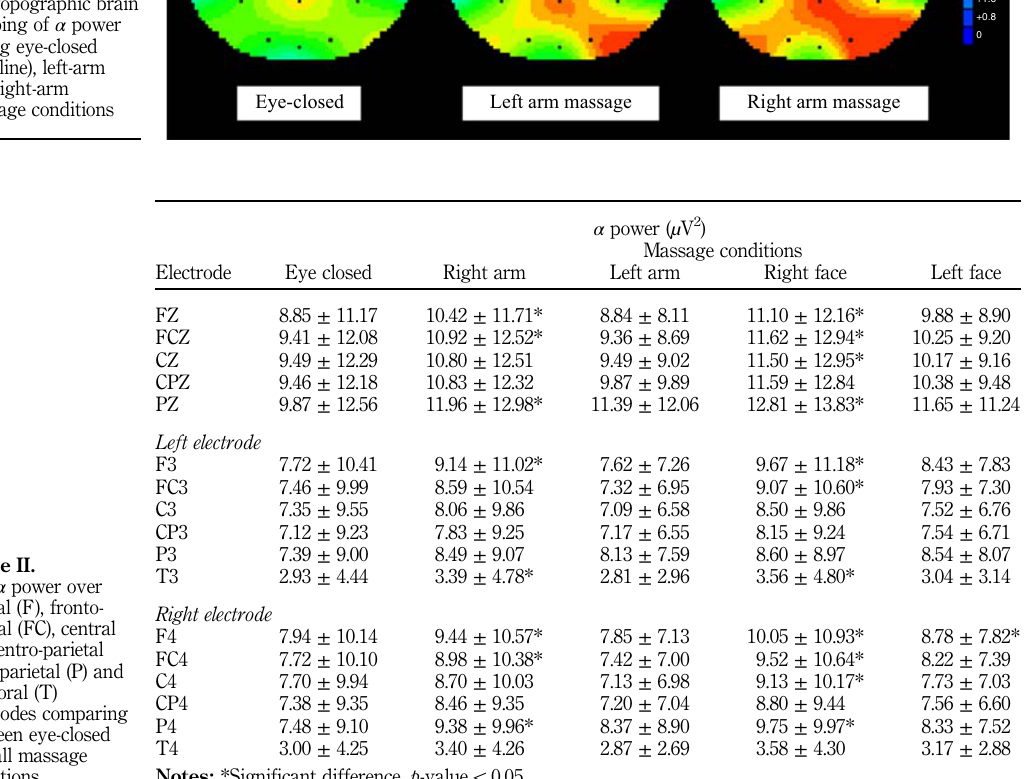
Figure 4. The topographic brain mapping of α power during eye-closed (baseline), left-arm and right-arm massage conditions